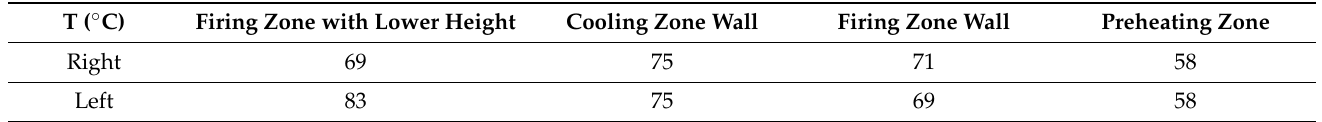
Table 12. Average temperatures obtained by the zone of the kiln walls on the right and left sides. Firing Zone Wall